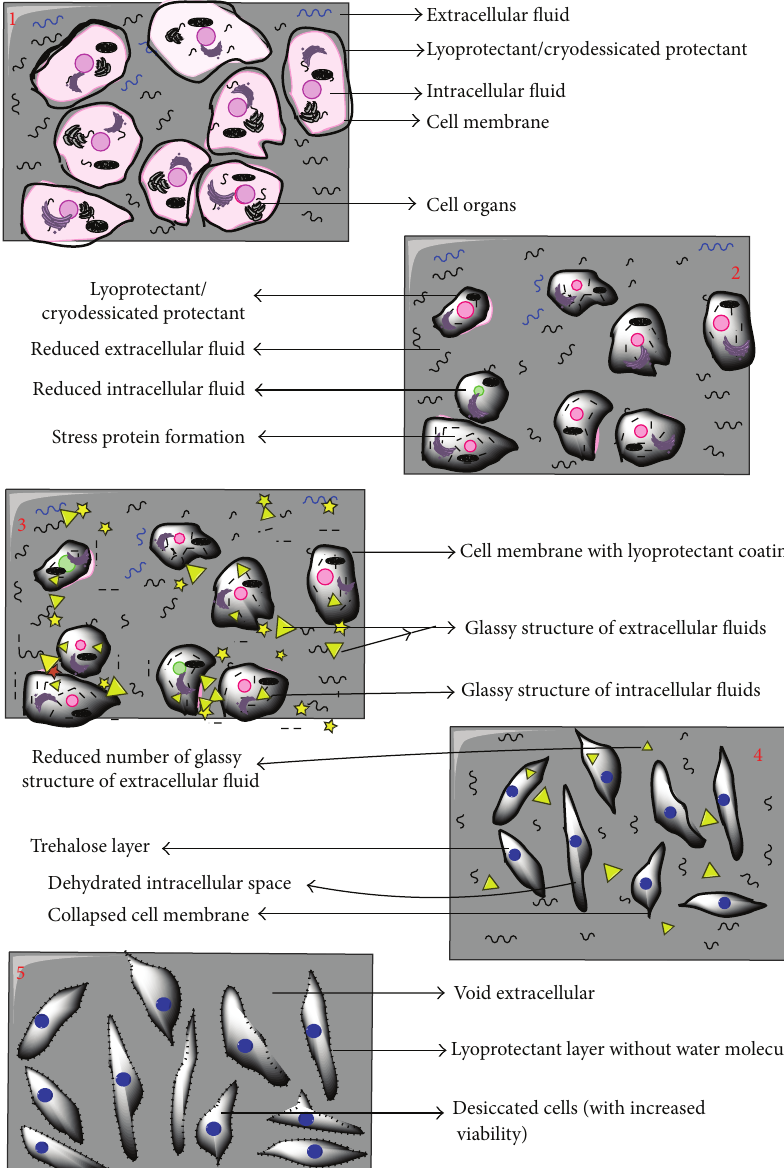
Figure 3: Hypothesized physiological changes being observed in cells following red path for desiccation-lyophilisation phase.